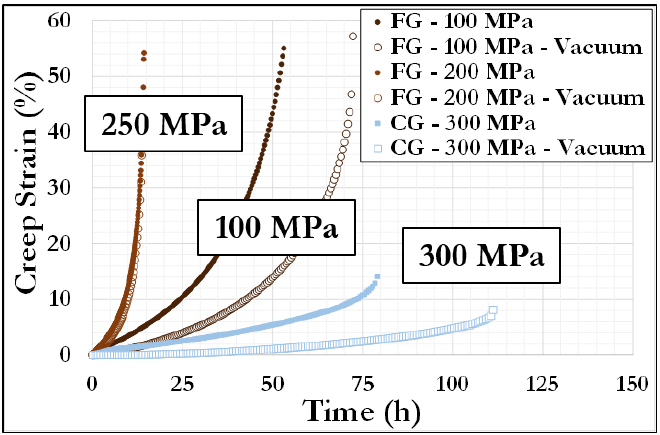
Figure 3. Comparison between creep tests performed under air and vacuum at 850